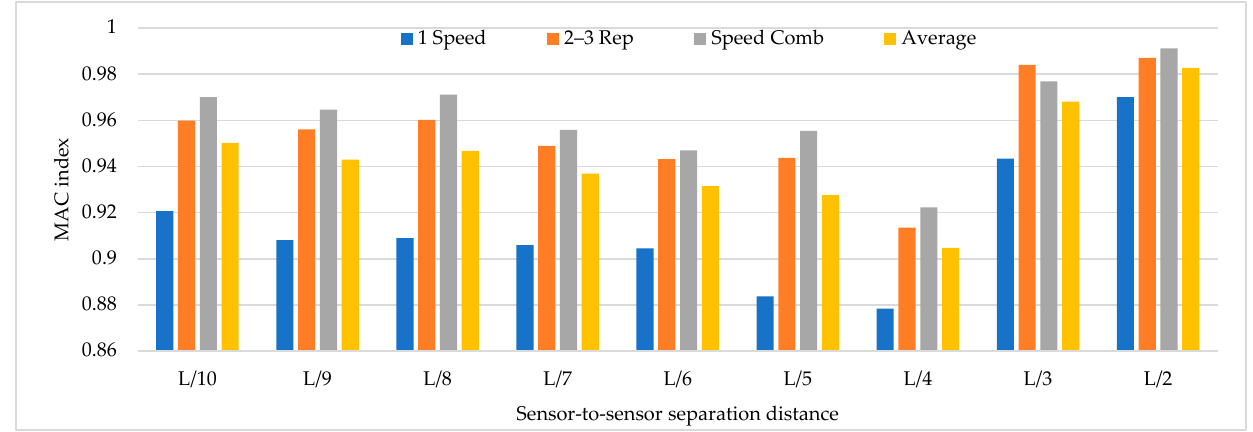
Figure 6. MAC index results for different sensor-to-sensor separation distances.